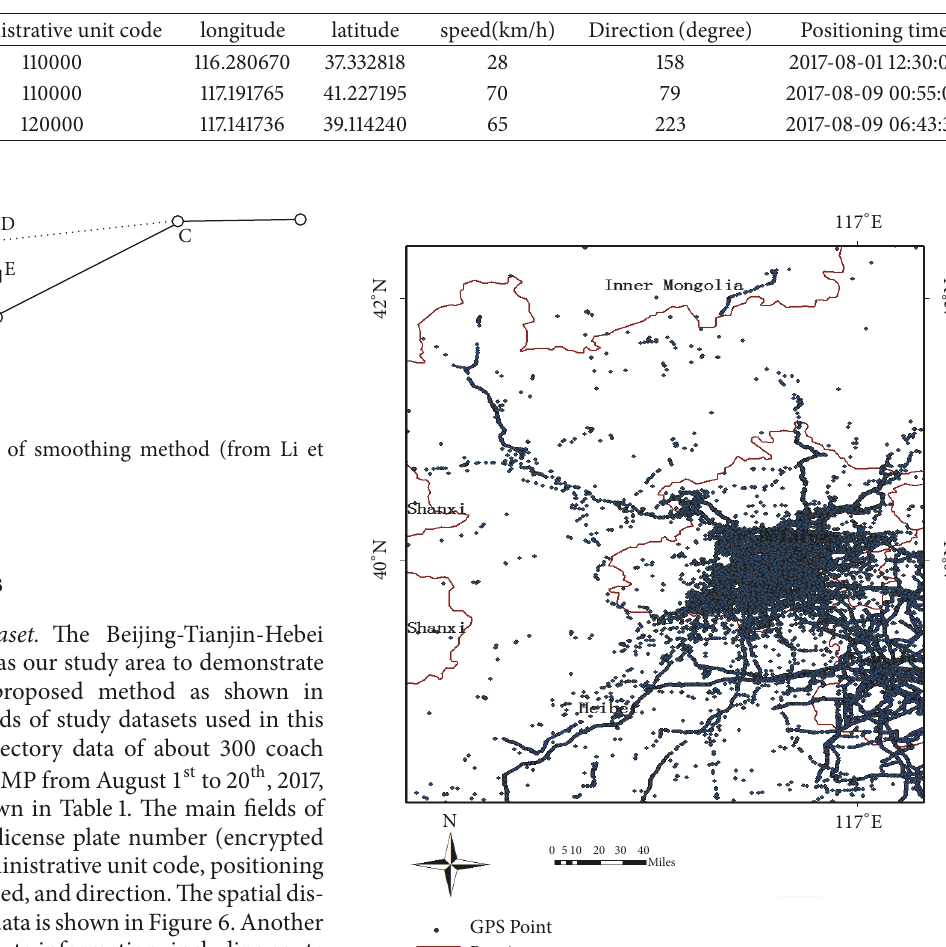
Table 1: Sample GPS data of passenger vehicles.